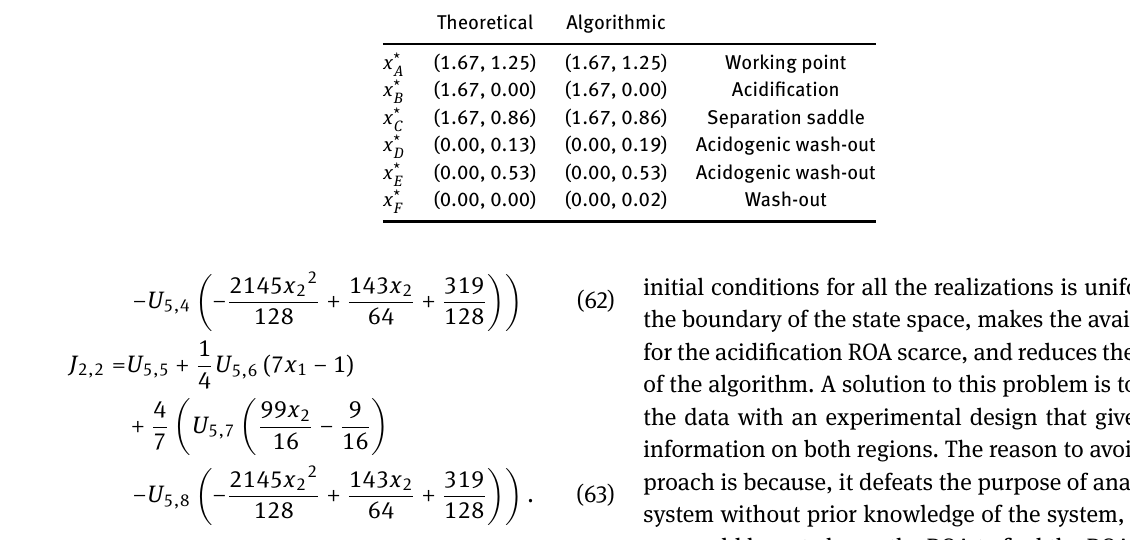
= 75 , and x in = 160 1 2